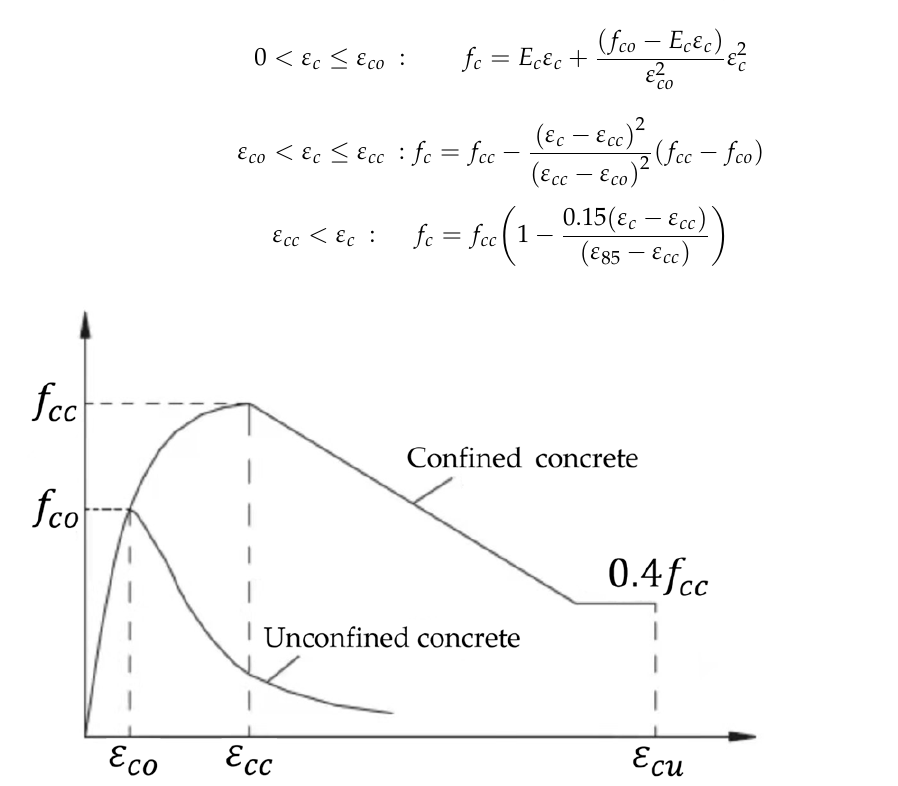
Figure 10. Stress–strain curve of confined concrete.